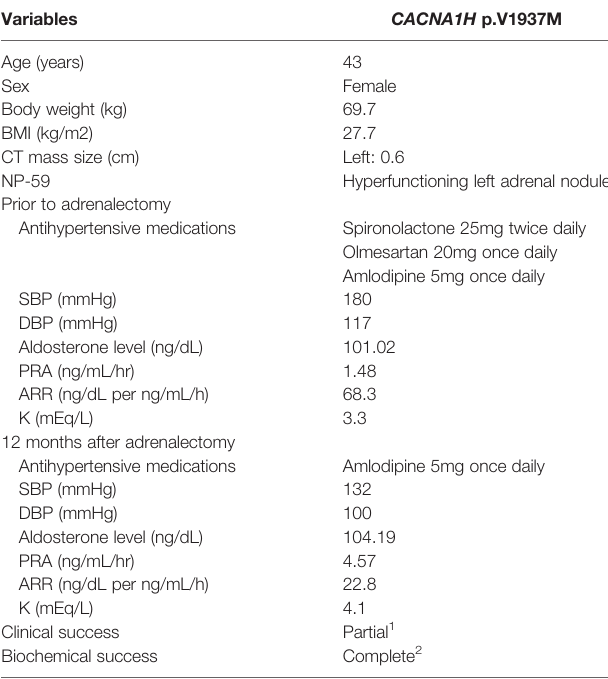
TABLE 2 | Clinical characteristics of the PA patient with a nodule harboring CACNA1H p.V1937M Variant. Variables